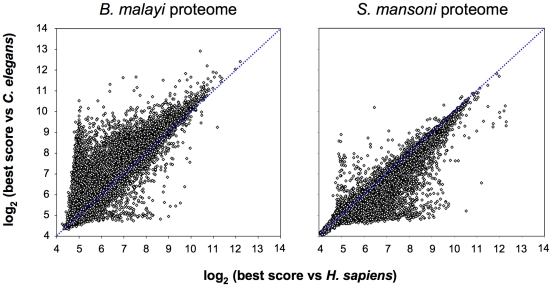
Scatter plot of the blast scores of all proteins from B. malayi (left) and S. mansoni (right) vs. the host H. sapiens (x-axis) and the control C. elegans (y-axis).Points below the blue dotted line represent parasite proteins with better scores to H. sapiens than to C. elegans.